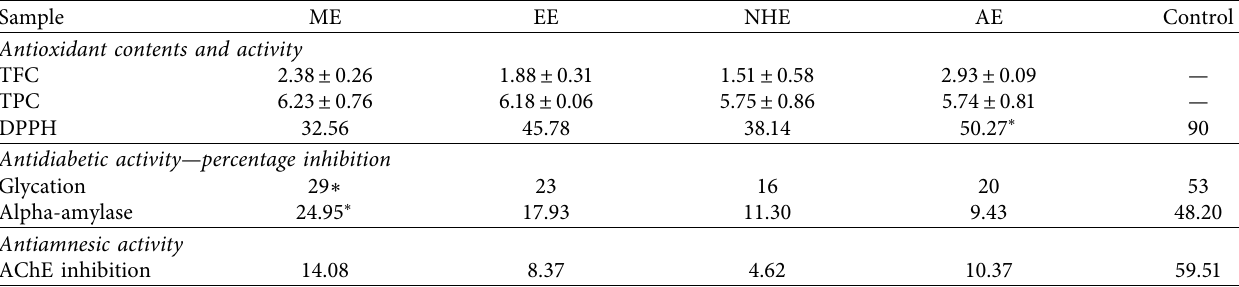
Table 4: Diferent extracts and biological efcacies of Trigonella foenum-graecum leaf.